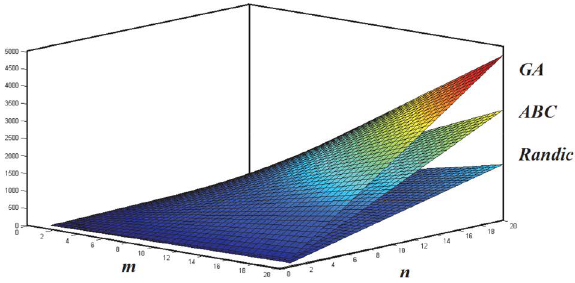
Figure 3 . A comparison of Randic , ABC and GA indices of OT [ m, n ]; m, n ∈ {1, 20} .